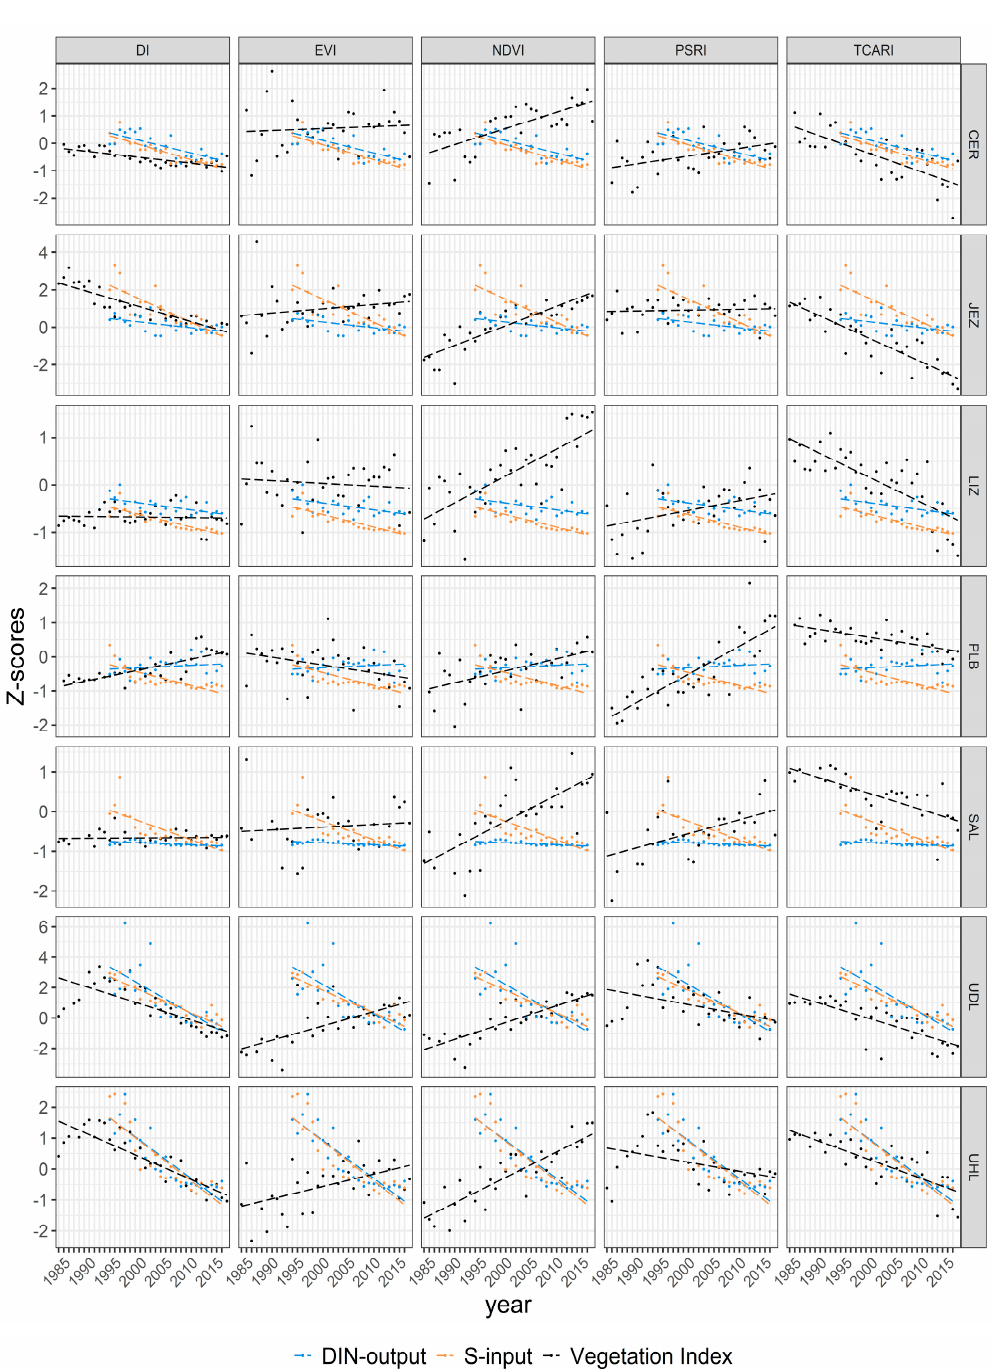
Figure 5. Trends (dashed lines) in long-term standard scores for measured sulfur deposition (S-input) and stream water dissolved inorganic nitrogen export (DIN-output) during the observation period 1994–2016 and trends in vegetation indices extracted from Landsat satellite data for the observation period 1984–2016. Only 7 out of 13 stream catchments were shown here, as they well represented the geographic areas in the Czech Republic and overall variety among the catchments. Trends for all of the catchments are presented in Figure S1, available online in the Supplementary Materials.